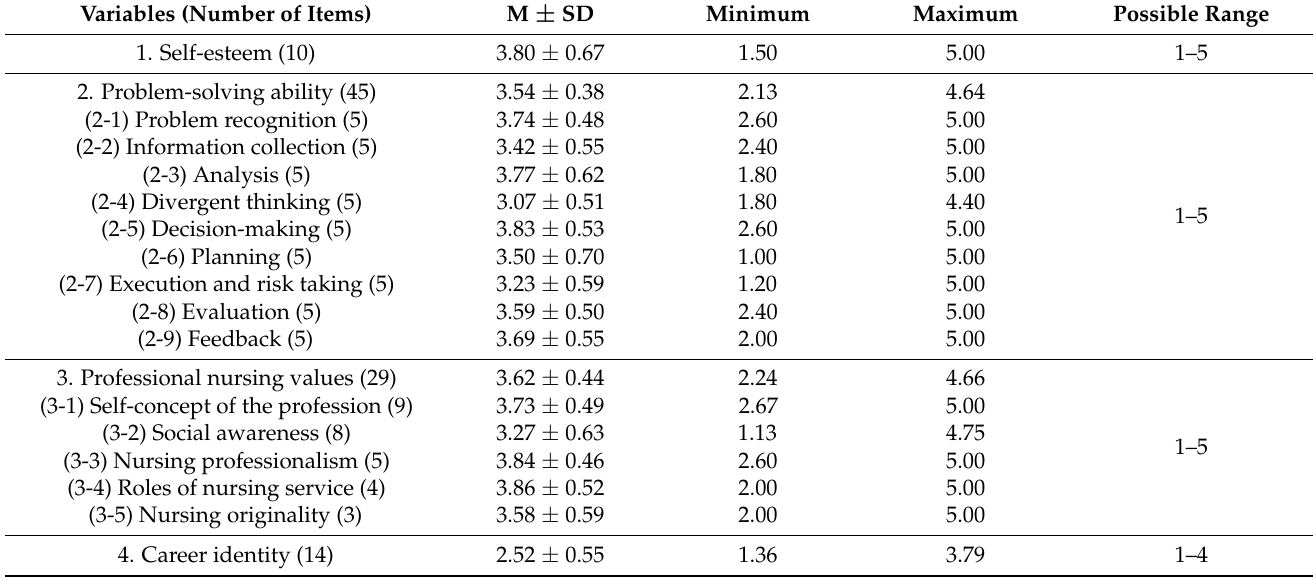
Table 2. Descriptive statistics for variables ( N =